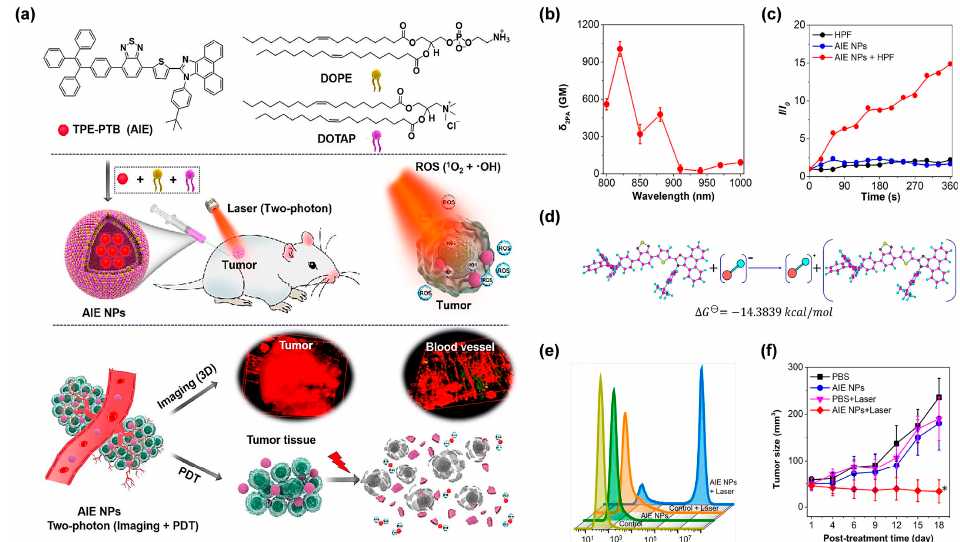
Figure 7. ( a ) Chemical structure of TPE-PTB and illustration of two-photon-excited FLI-guided PDT applications. ( b ) δ 2PA of the TPE-PTB NPs under different excitation wavelengths. ( c ) OH • production ability of TPE-PTB NPs indicated by HPF. ( d ) Mechanism and calculation of OH • generation analysis. ( e ) Flow cytometry of A375 cells stained by PI after treatment with different conditions. ( f ) Tumor growth curves of mice in different treatments. (* p < 0.05). Reprinted with permission from [66], copyright 2020, American Chemical